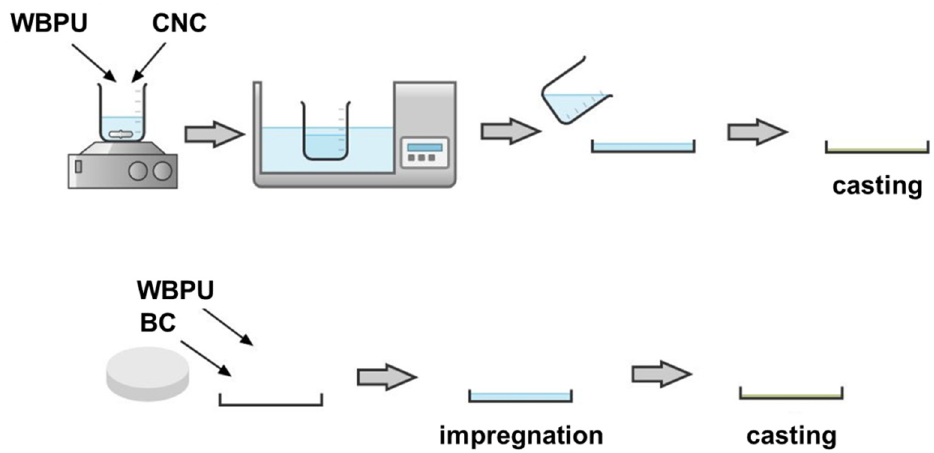
Figure 1. Preparation of the films containing waterborne polyurethane (WBPU) and cellulose nanocrystals (CNCs) or bacterial cellulose (BC).